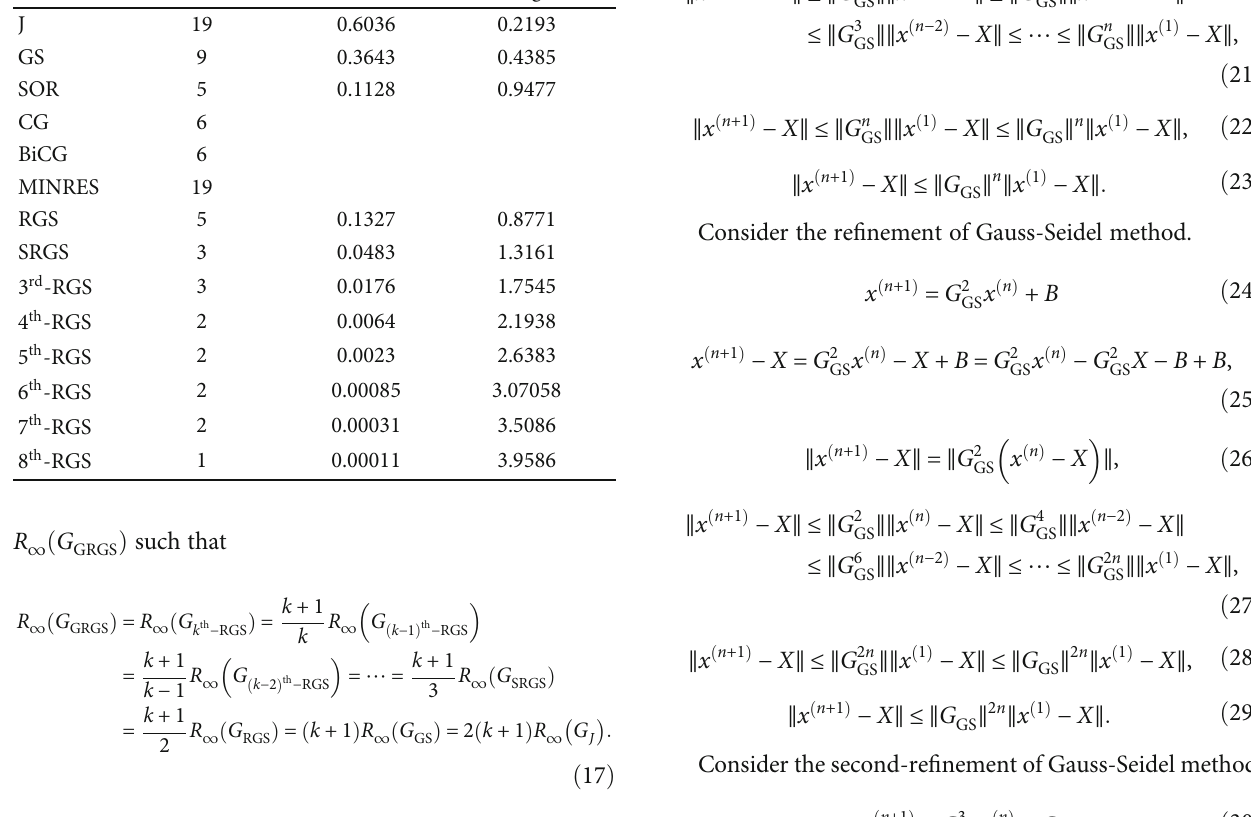
Table 1: Comparison of J, GS, SOR, and GRGS methods.